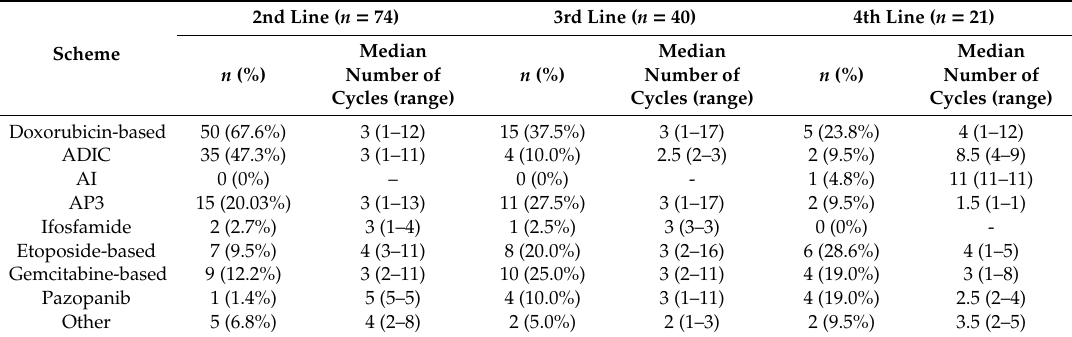
Table 4. Summary of most commonly used systemic therapies in the second, third, and fourth line of